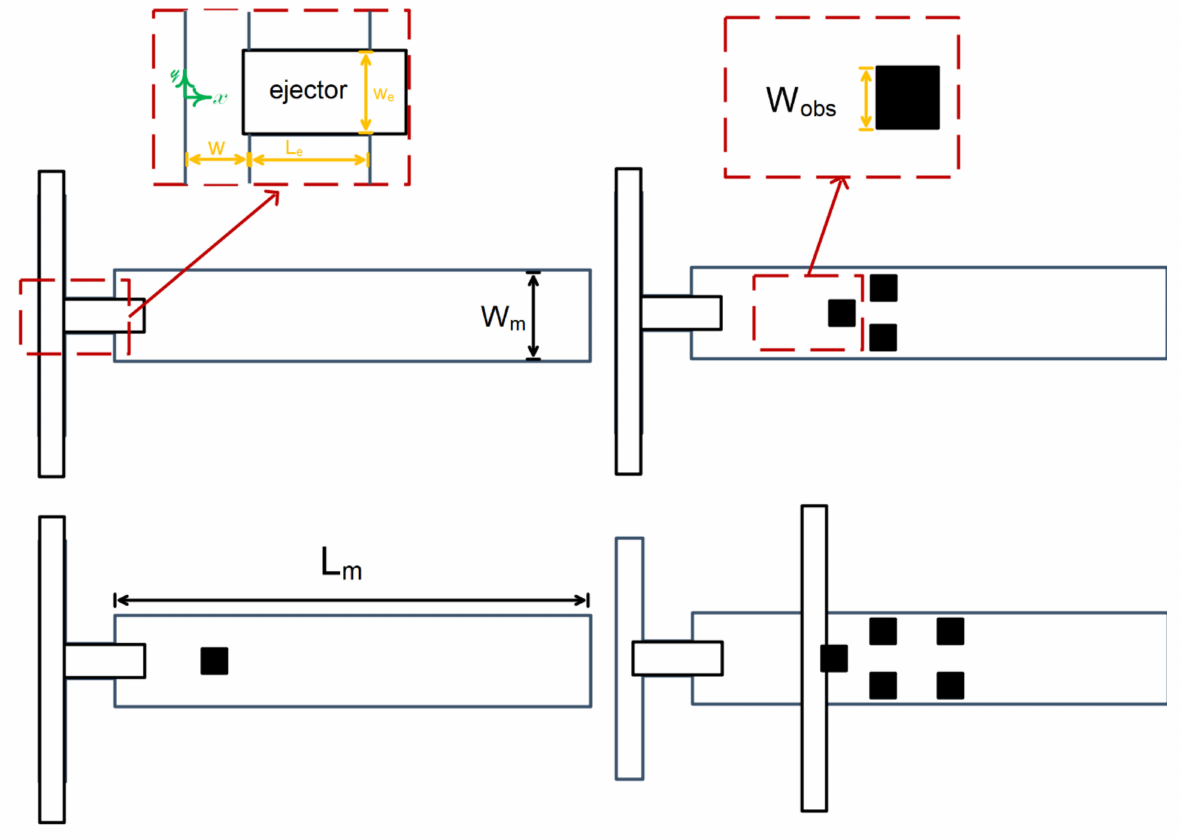
Figure 30. Schematic representation of the mixers studied